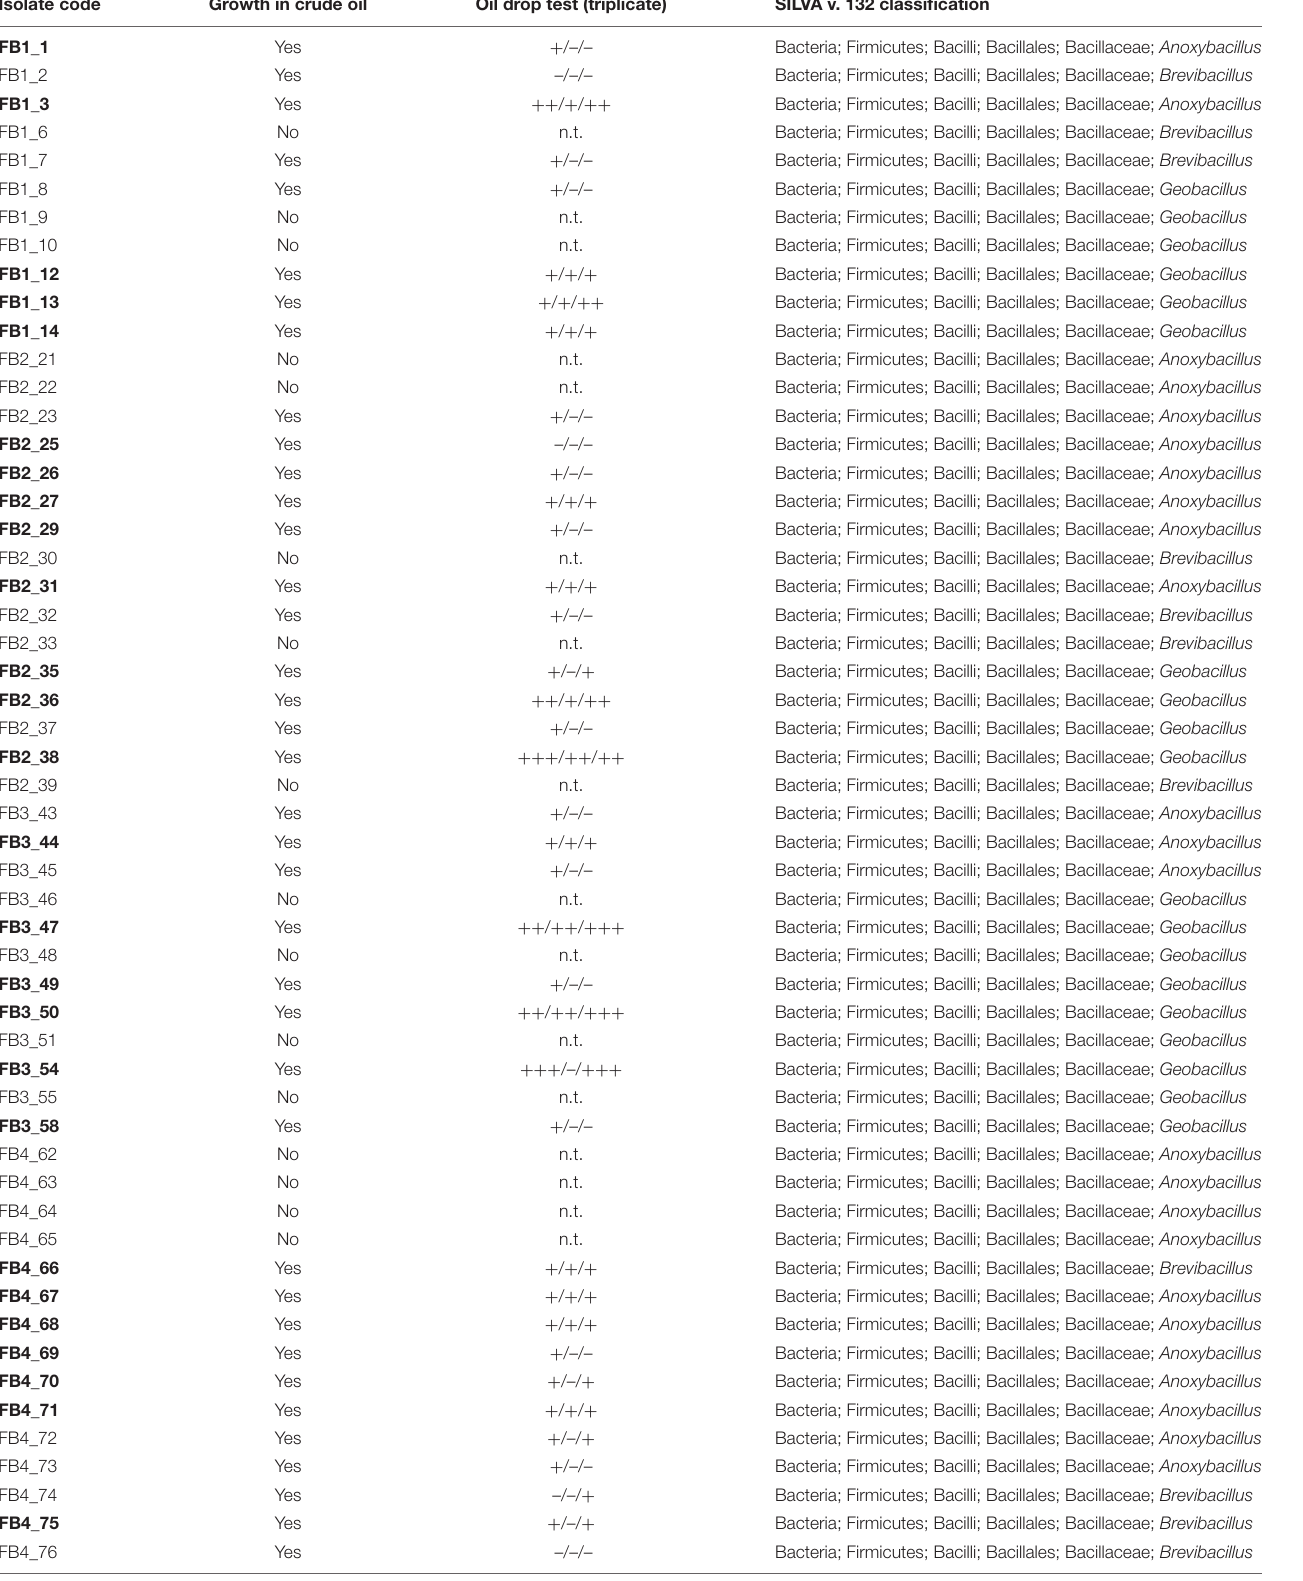
TABLE 1 | List of thermophiles from Deception Island, Antarctica, capable of degrading crude oil and use as a carbon source, and their molecular identification. Isolate